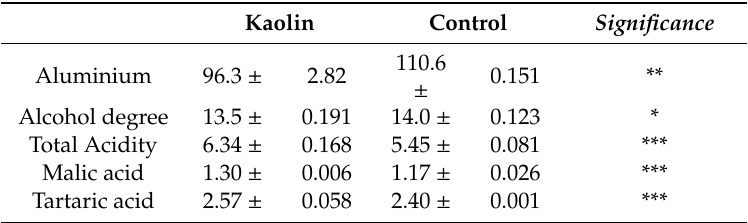
Table 7. Aluminum concentration ( µ g g − 1 ), total acidity (g L − 1 of tartaric acid), pH, alcohol degree (%, v / v ), and tartaric and malic acid concentration (g L − 1 ) of wine of white ‘Cerceal’ cv. from Kl treated and untreated (control) grapevines. Values are presented as mean ± SD. Significant di ff erences are presented between treatments and considered for p < 0.05 and *** p < 0.001, ** p < 0.01, * p < 0.05 represent significant di ff erences.